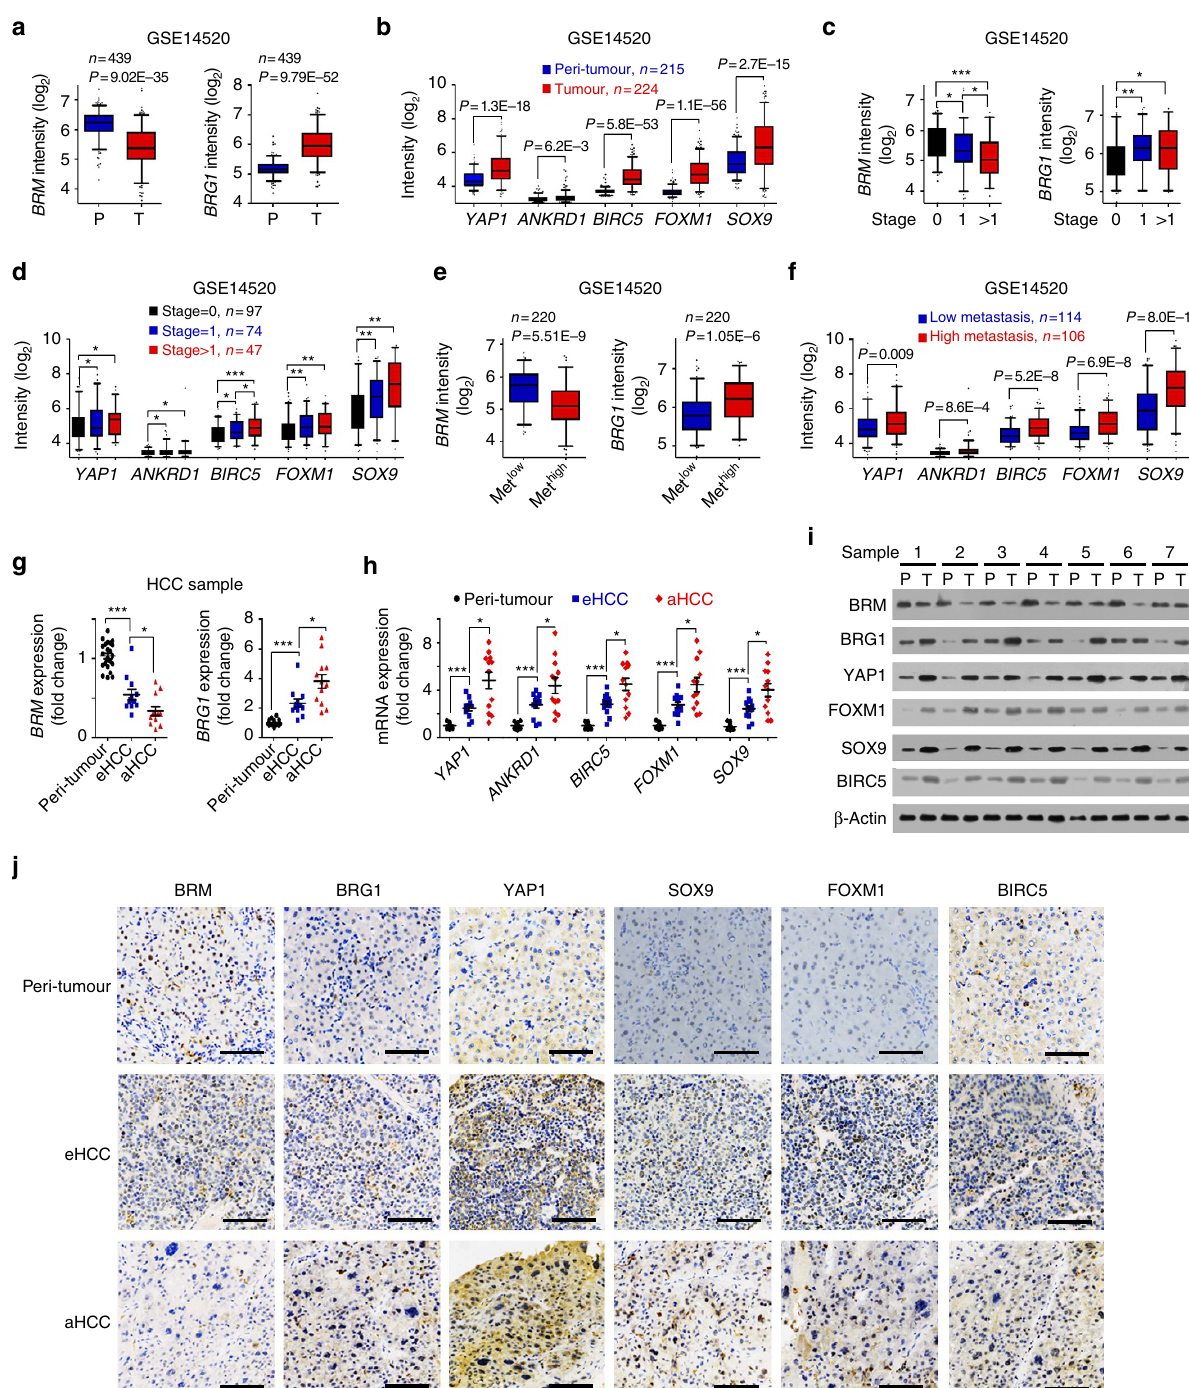
Figure 7 | Expression levels of BRG1 and YAP1 targets are positively correlated with severity and prognosis of HCC patients. ( a ) Decreased BRM expression (left panels) and increased BRG1 expression (right panels) in HCC tumour tissues derived from Wang’s cohort (GSE14520). R language was used for gene expression analysis. P, peri-tumour; T, tumour. ( b ) Expression levels of YAP1 and its target genes in peri-tumour and tumour tissues were analysed using R language and Bioconductor, and shown as box and whisker plot. ( c ) Increased BRG1 expression (left panel) and decreased BRM expression (right panel) in advanced HCC patients according to Wang’s cohort (GSE14520). ( d ) High expression levels of YAP1 and its target genes in high metastasis samples derived from Wang’s cohort (GSE14520). ( e , f ) Decreased BRM , increased BRG1 ( e ) and elevated YAP1 target genes ( f ) exhibited in high metastasis HCC patients according to Wang’s cohort (GSE14520). ( g ) Expression levels of BRG1 and BRM were examined in HCC primary samples